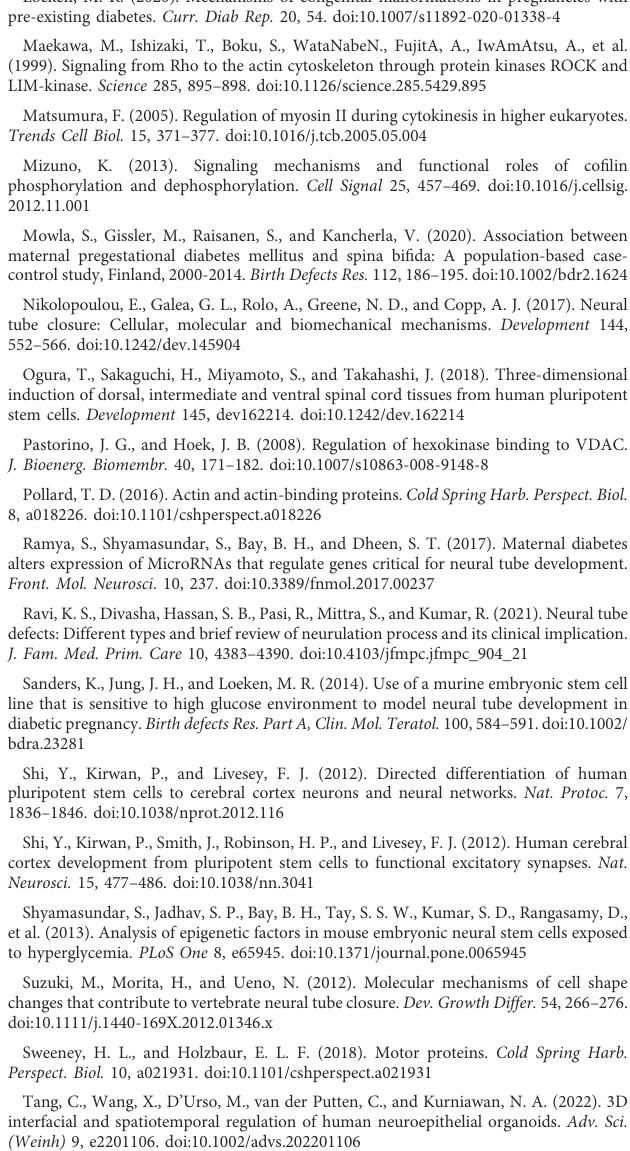
SUPPLEMENTARY FIGURE S1 High glucose increased the apoptosis at the end of rosettes culture. (A) Immuno fl uorescence imagesofCASP3 (green) inthenormal(NG)and 2x high glucose (HG)groups atD1-4after passage.DAPI(blue)shows thenucleus. All scalebaris50 μ m. (B) ThedensityofCASP3stainingweremeasuredbyImageJ software. N =15/condition. SUPPLEMENTARY FIGURE S2 High glucose had no obvious effect on the distribution of pMLC and pCFN in both models. Double immuno fl uorescence images of F-actin (red) and pMLC (green)( A,B) orpCFN(green) (C,D) wereperformedinthenormal(NG)and2x high glucose (HG) groups. ( A,C) are from 3D cyst models at D1, 2, 5. (B,D) are from 2D rosette models at D3,4 after passage. N ≥ 6/condition. DAPI (blue) shows the nucleus. All scale bar = 50 μ m.